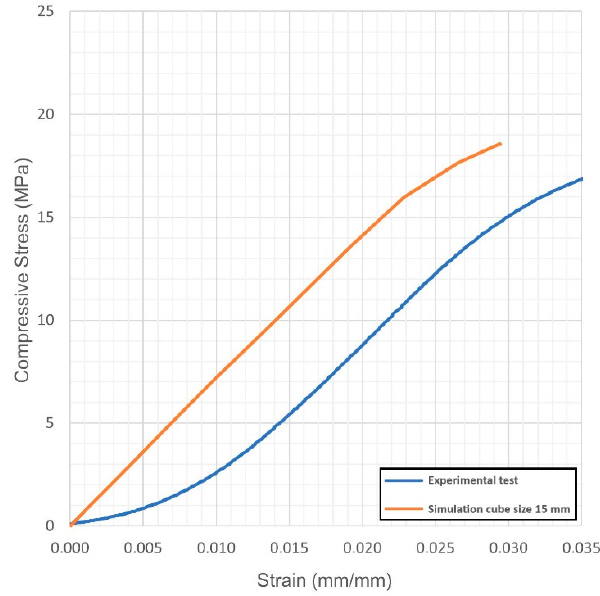
Figure 7. Condition 2, stress-strain diagram; comparisons between simulated and actual specimens.